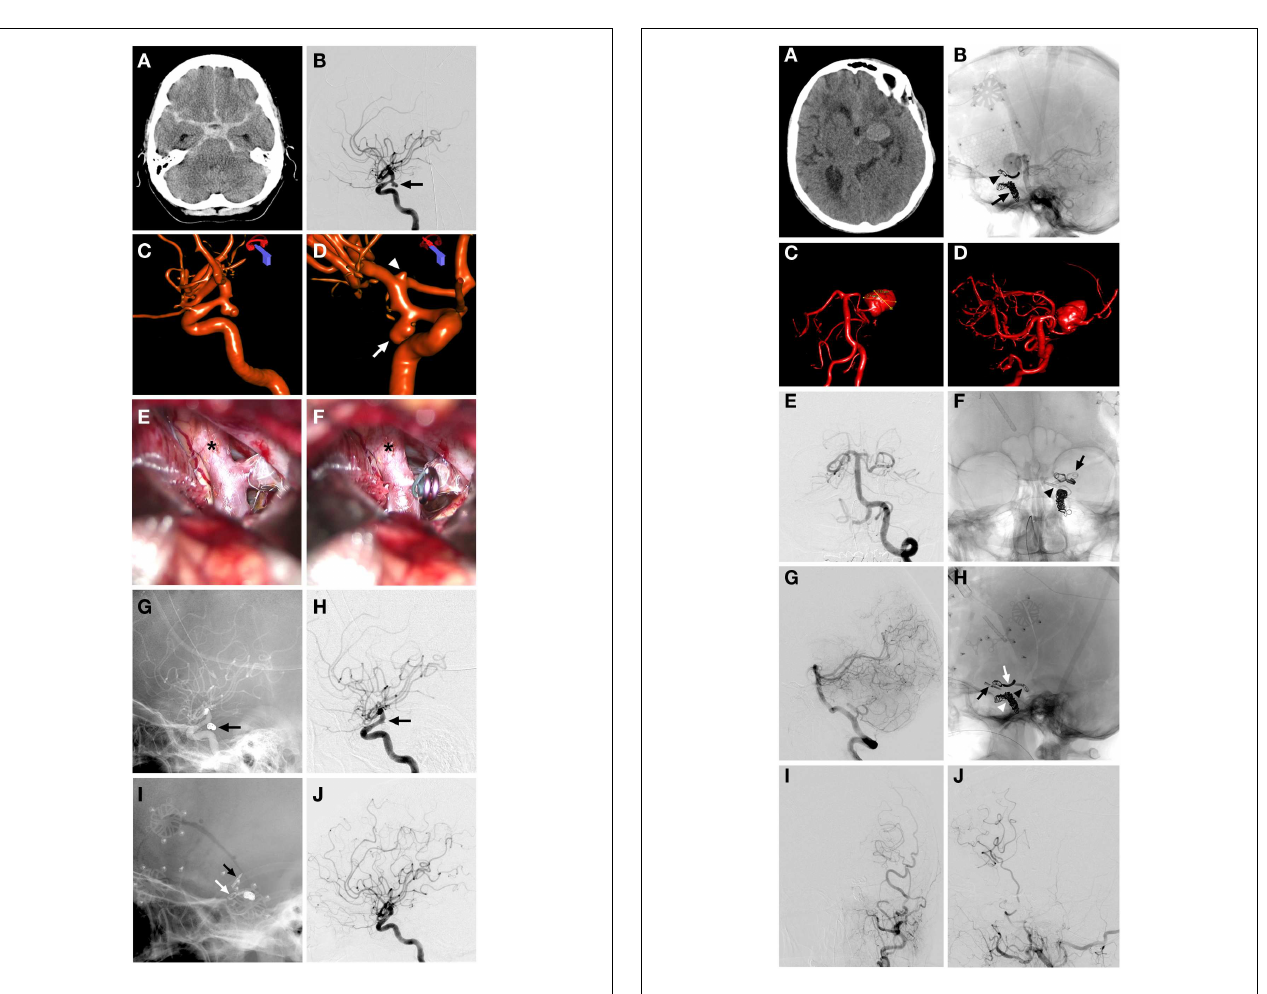
supraclinoid ICA giant aneurysm. The patient also had new onset of right facial droop with right hemiparesis and aphasia.A cerebral angiogram confirmed the presence of an approximately 2.6